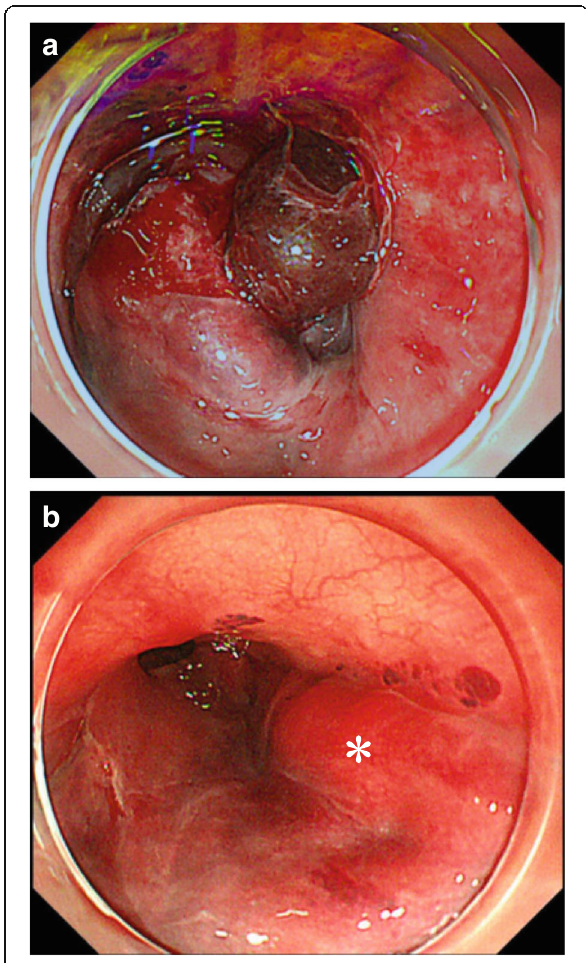
Fig. 2 Upper gastrointestinal endoscopy images after hematemesis. a The submucosal hematoma occupied the oesophagus. b , a Longitudinal extension of reddish or wine-coloured mucosal thickening (asterisk), obstructing the oesophagus, is seen from the cervical oesophagus to the thoracic